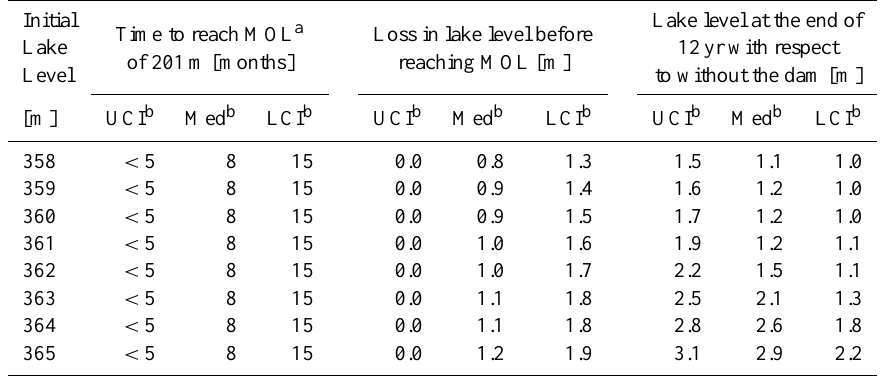
Table 4. Lake level fluctuations modeled using a nonparametric bootstrap resampling (NBR) technique for the period of 12yr from the commencement of the dam.